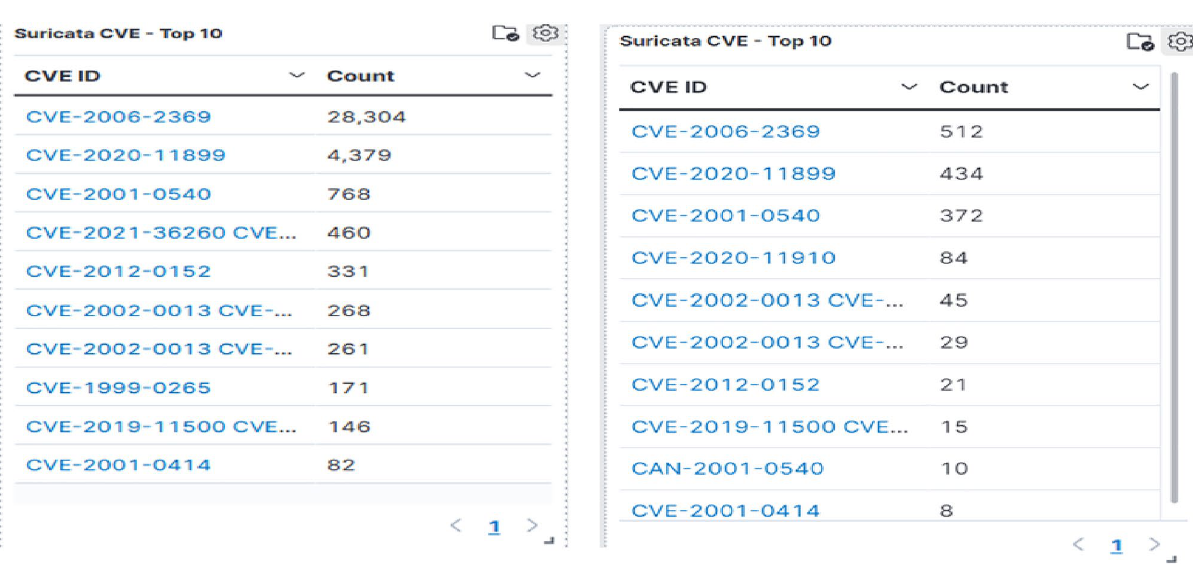
Figure 10. List of operating systems utilized by the intruders for launching invasion.